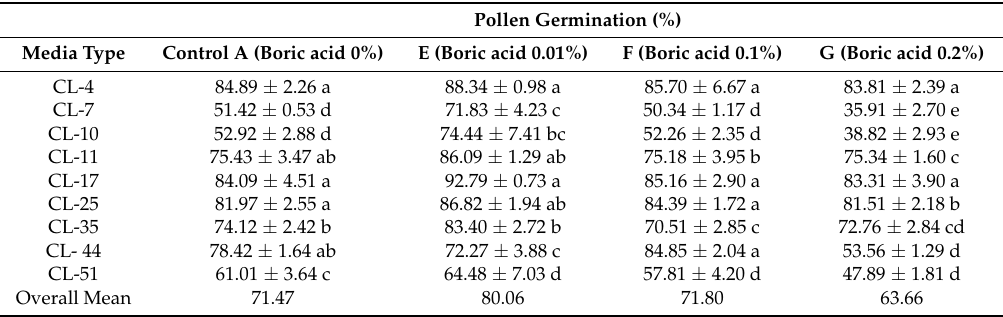
Table 4. Effects of boric acid concentration on pollen